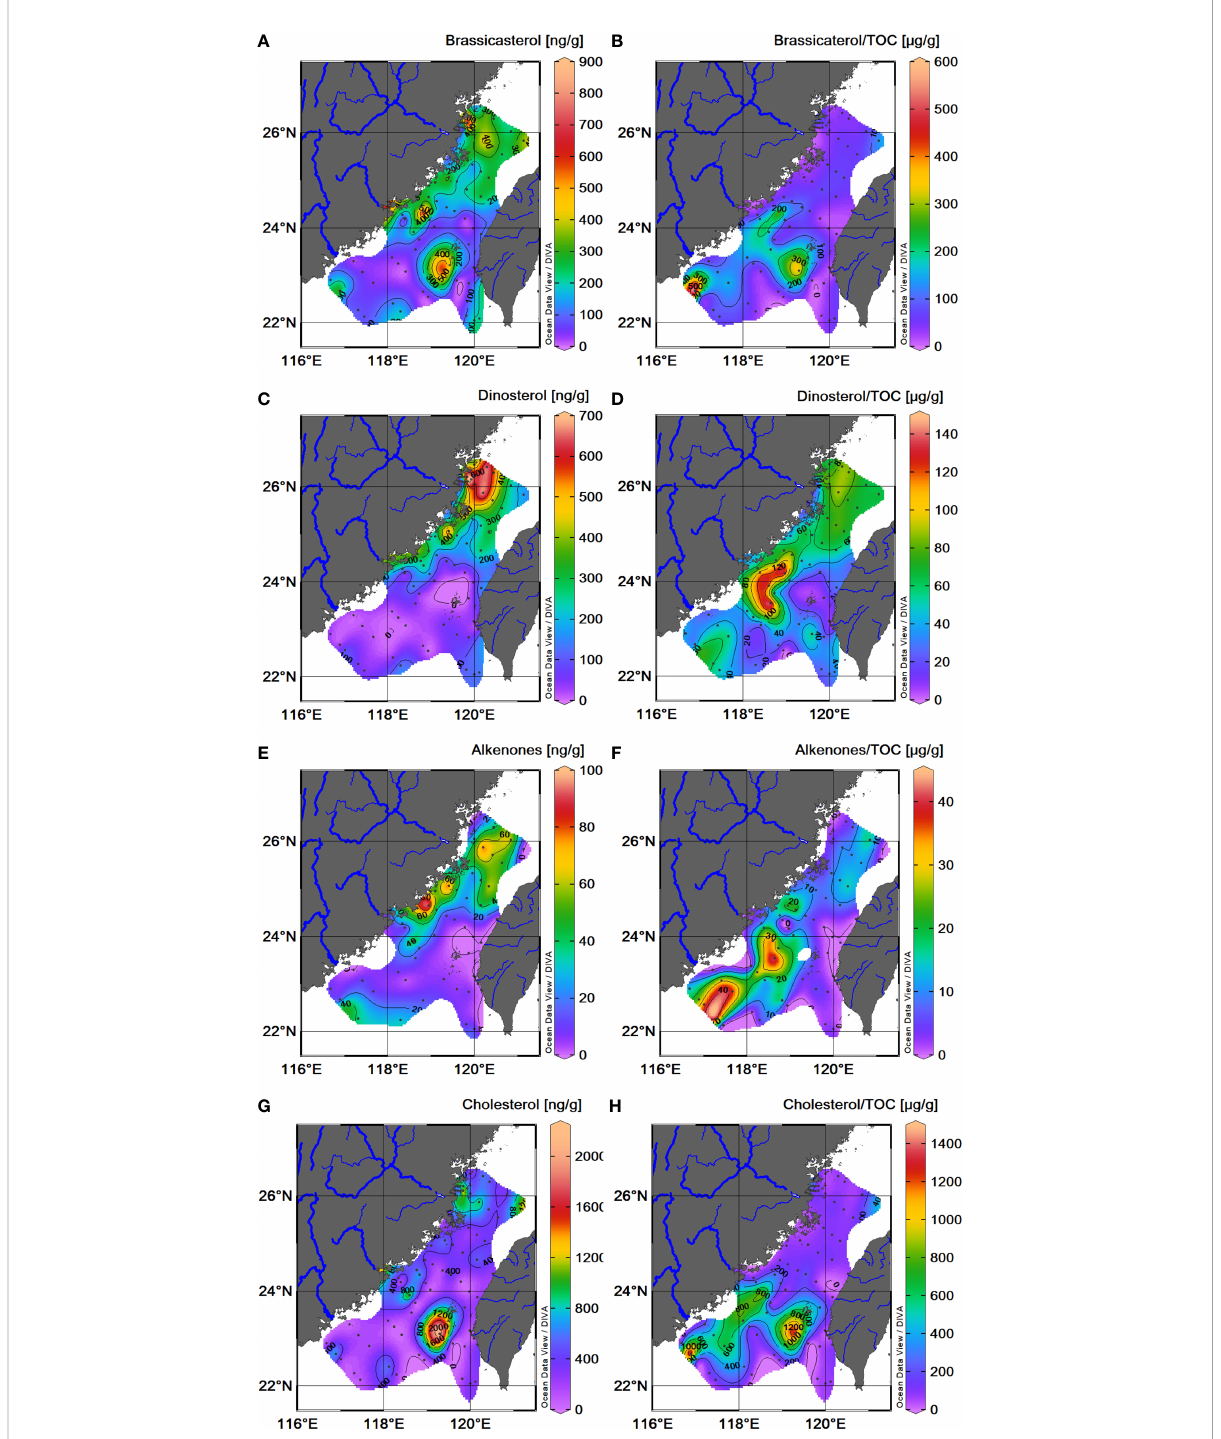
FIGURE 5 Spatial distributions of phytoplanktonic biomarker contents in TS surface sediments. Sediment dry weight and TOC-normalized brassicasterol content (A, B) ; dinosterol content (C, D) ; alkenones (C 37:2 + C 37:3 ) content (E, F) ; cholesterol content (G, H)